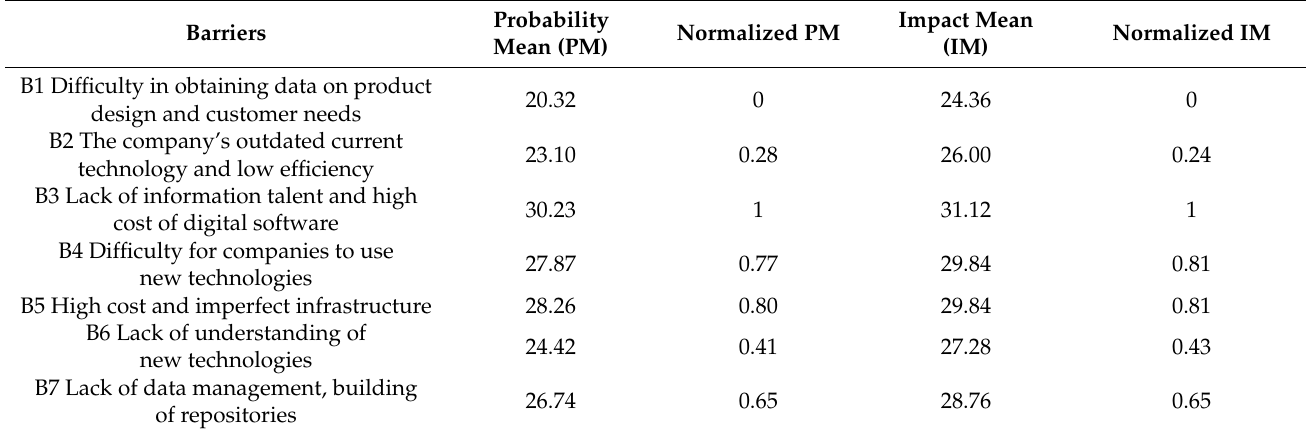
Table 5. Probability and impact